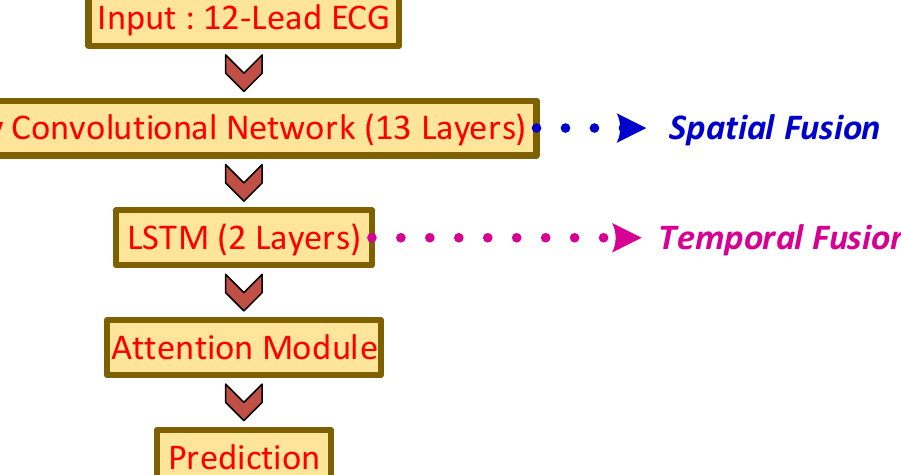
Figure 3. Architecture of attention-based time-incremental convolutional neural network based on